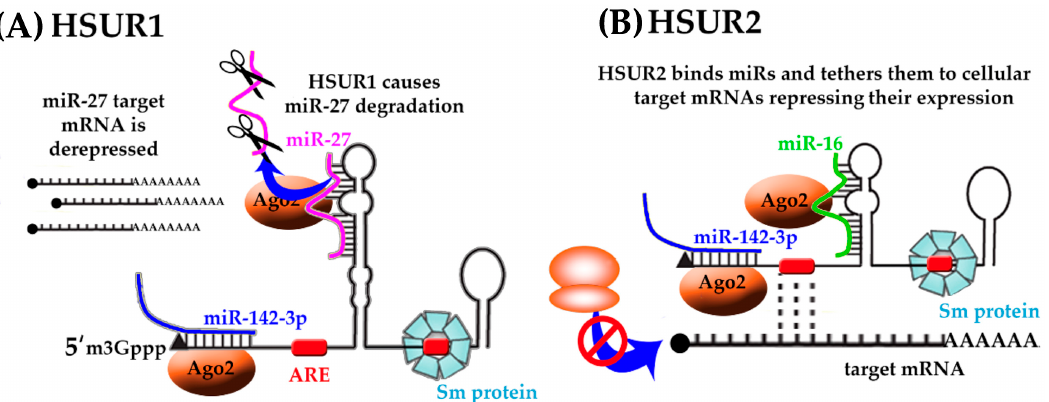
Figure 4. Putative functions of HSUR RNAs ( A , HSUR1; B , HSUR2). HSURs have been found to have highly conserved regions responsible for binding of host miRNAs, i.e., miR-16 (green), miR-27 (pink), miR-142 (blue) and host proteins, i.e., Ago2 (orange), involved in RISC complex formation, spliceosomal Sm proteins (blue). While the exact mechanism and function of HSURs are not yet understood the recruitment of host miRNAs and proteins likely regulates gene expression of the target messenger RNA.